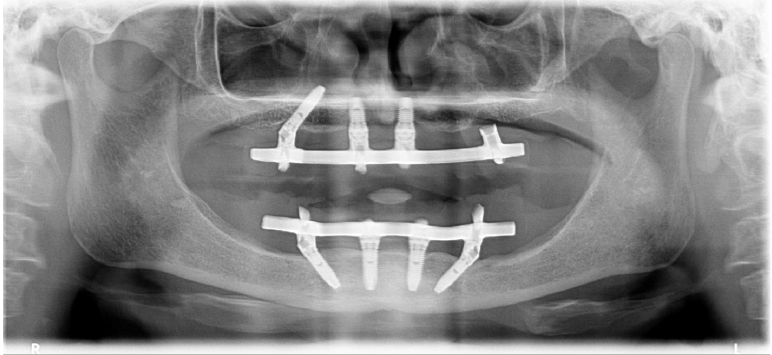
Figure 18. Patient smiling with the immediate full-arch implant-supported fixed prosthesis after 6 months of follow-up.